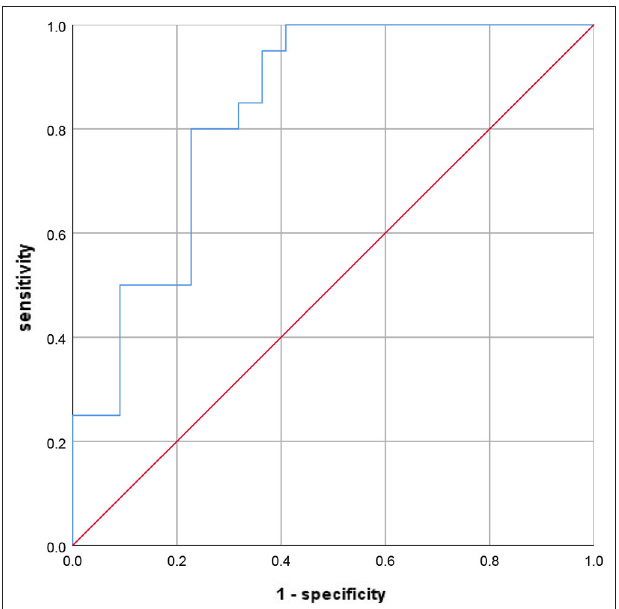
FIGURE 2 | The ROC curve to evaluate the diagnostic value of 15-PGDH for SAP. ROC, receiver operating characteristic; SAP, stroke-associated pneumonia; 15-PGDH, 15-hydroxyprostaglandin dehydrogenase.